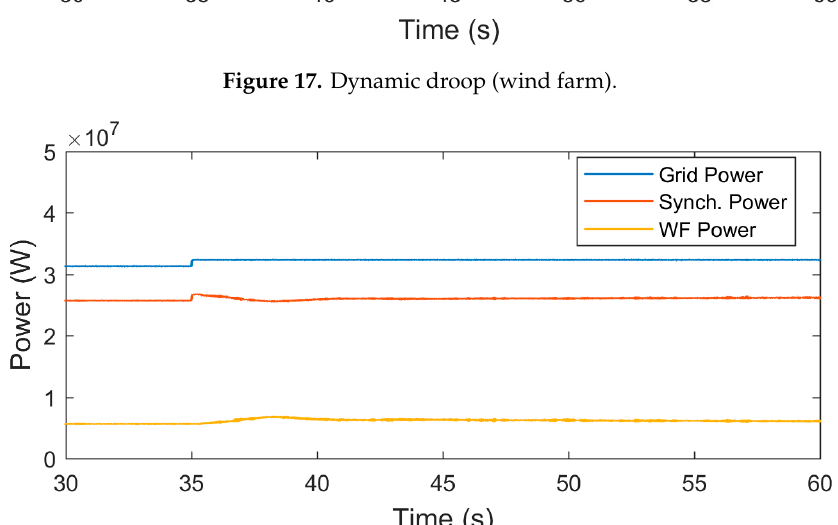
Figure 18. Power: grid, synchronous generator, and wind farm.